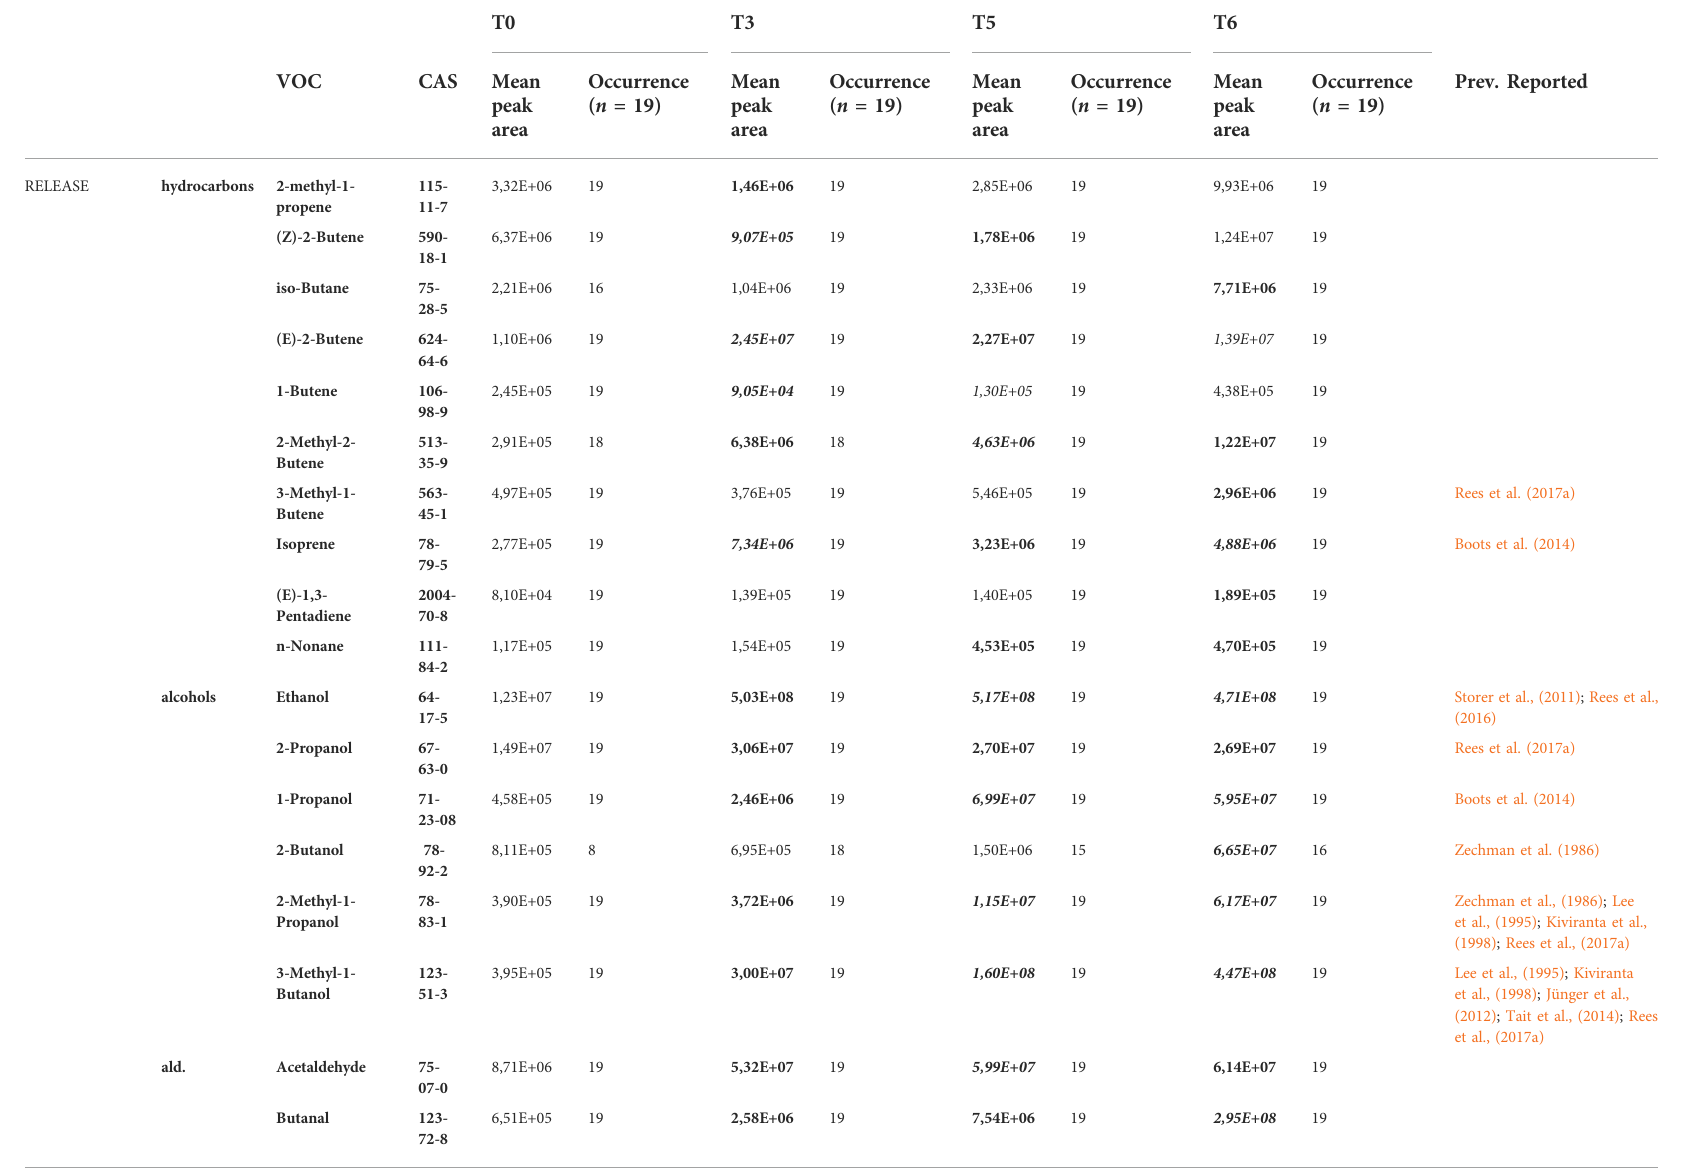
TABLE 5 Statistically signi fi cant VOCs observed in the culture headspace of KPN clinical